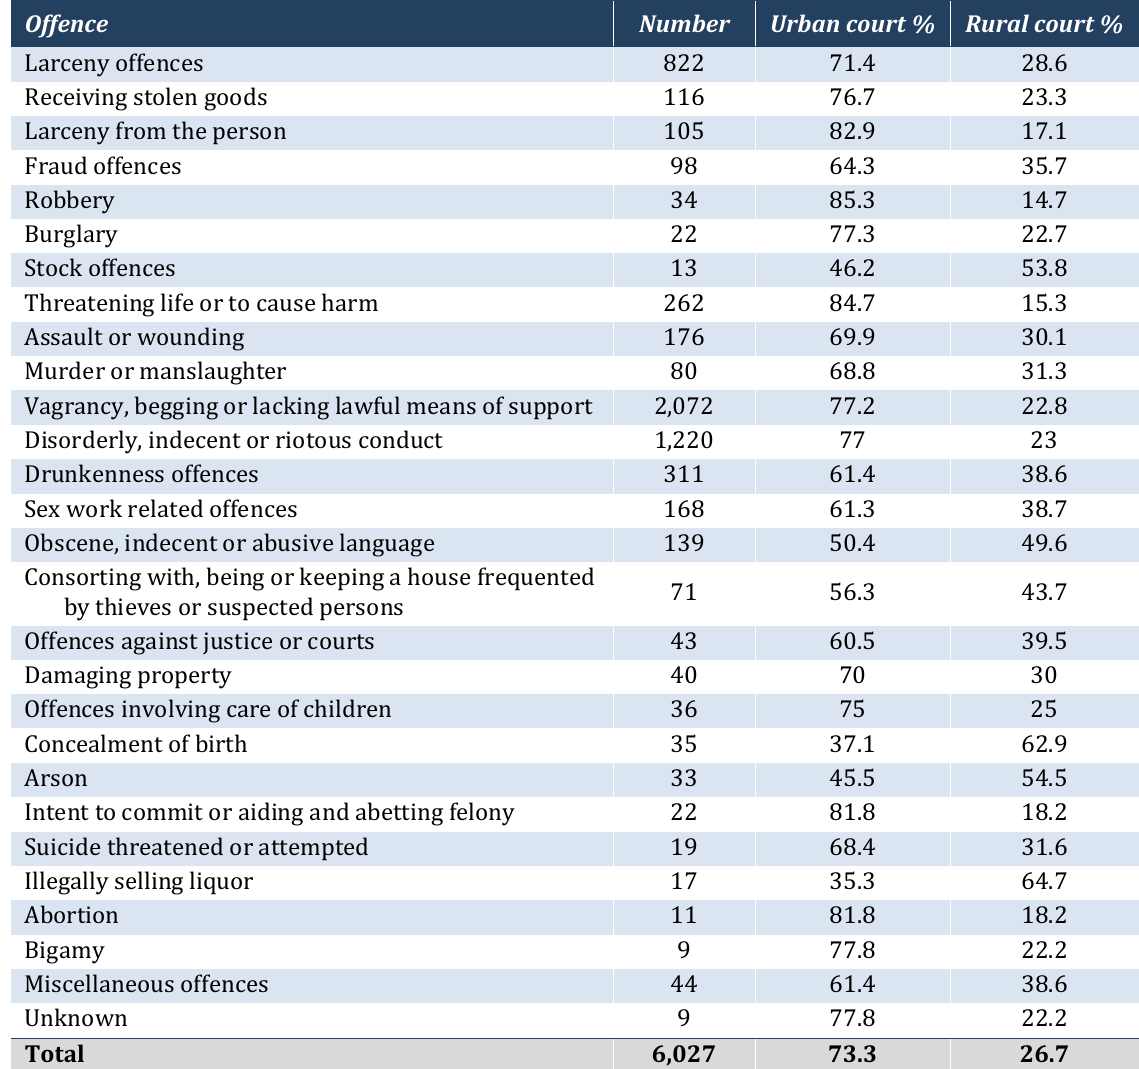
Table 2: Type of offence for women first imprisoned against location of court where convictions